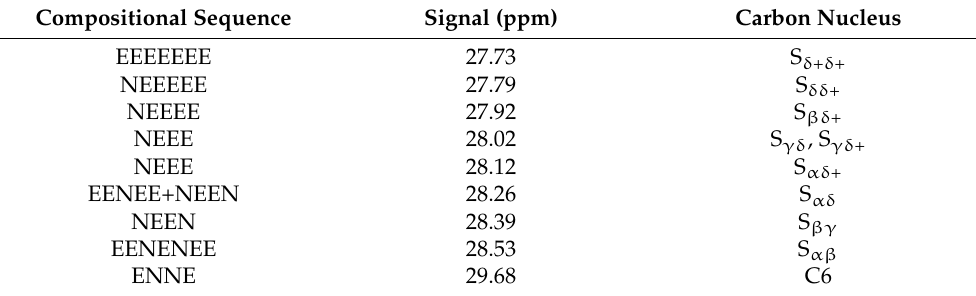
Table 4. Compositional sequences for resultant copolymers.